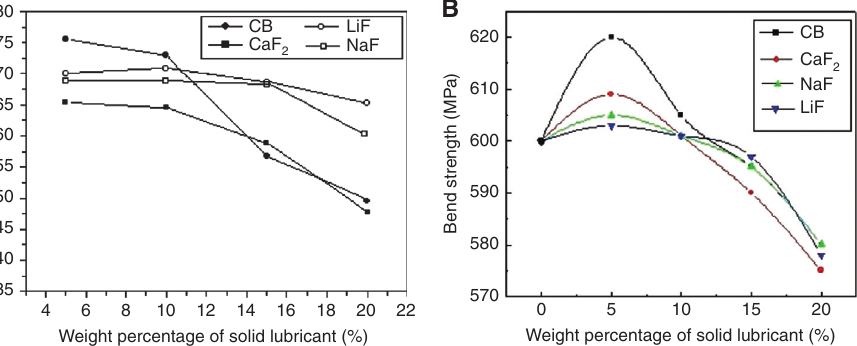
Figure 7 The effect of addition amounts of different solid lubricants on hardness and bend strength: (A) hardness and (B) bend strength.